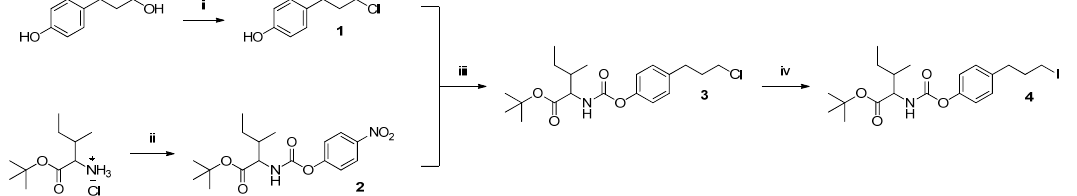
Scheme 2. Synthesis of intermediate 4 . Reagents and conditions: ( i ) HCl 37%, 100 ◦ C overnight, 99% yield; ( ii )